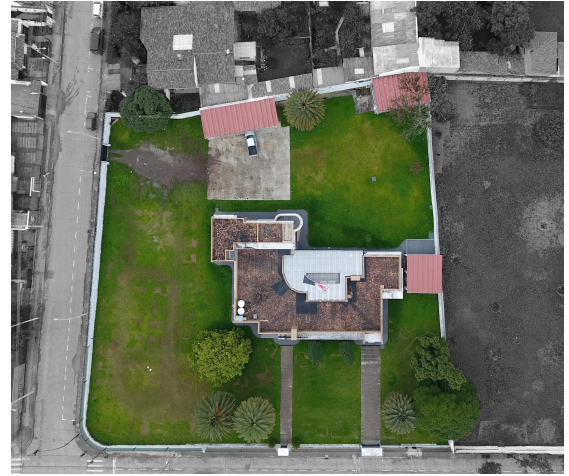
Figure 2. Aerial picture from the case study ¨Casa Peña ̈